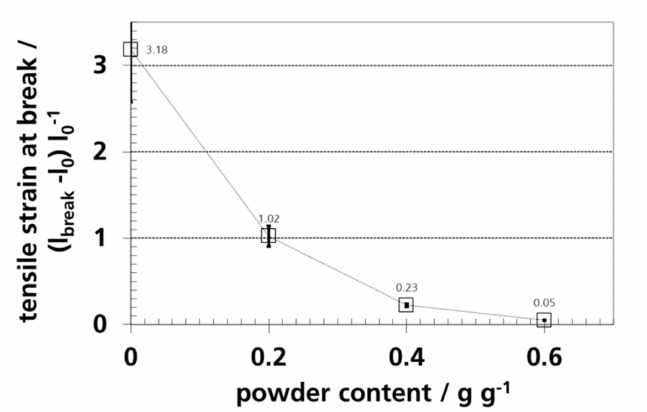
Figure 12. Tensile strain at break of PE-LD films with di ff erent amounts of silica gel powder. The pure PE-LD-film had a similar tensile stress at break as the value reported by van Krevelen with 10 N / mm 2 [128], it was lower than the value of 25 N / mm 2 reported by Bleisch [127]. In the product data sheet for blown film (blowing ratio of 2:1), a tensile stress at break of 17 (transverse to machine direction) and 27 N / mm 2 (parallel to machine direction) is reported [57]. The values measured in